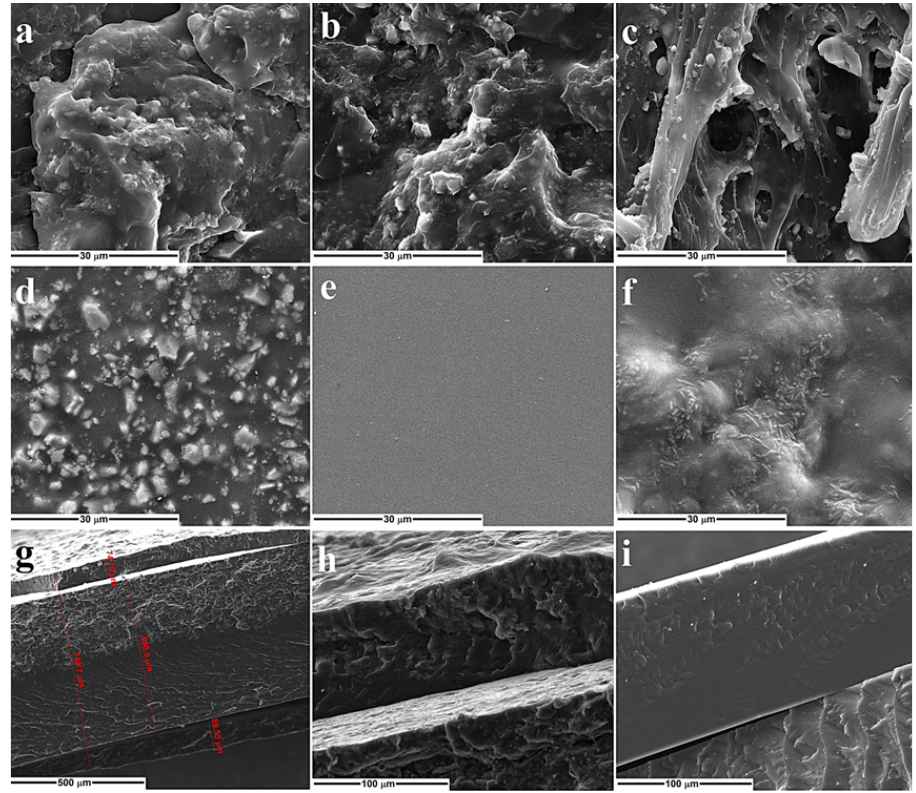
Figure 1. SEM images of the obtained samples: ( a ) cross section of control monolayer, M0; ( b ) cross section of M1; ( c ) cross section of M2; ( d ) surface of M2; ( e ) surface of M2p; ( f ) surface of M2f; ( g ) cross section of M1pf; ( h ) detail of M1pf cross section; ( i ) detail of M1p cross